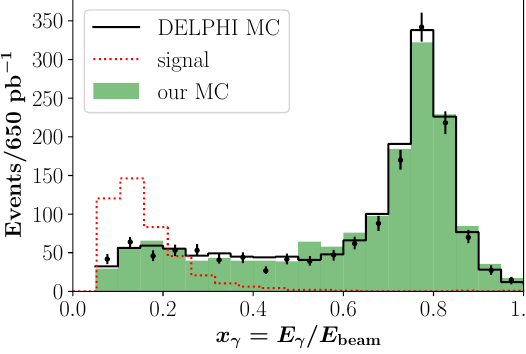
(cid:30) 2 (cid:30) (cid:3) (cid:13) and e + e (cid:0) 2 !